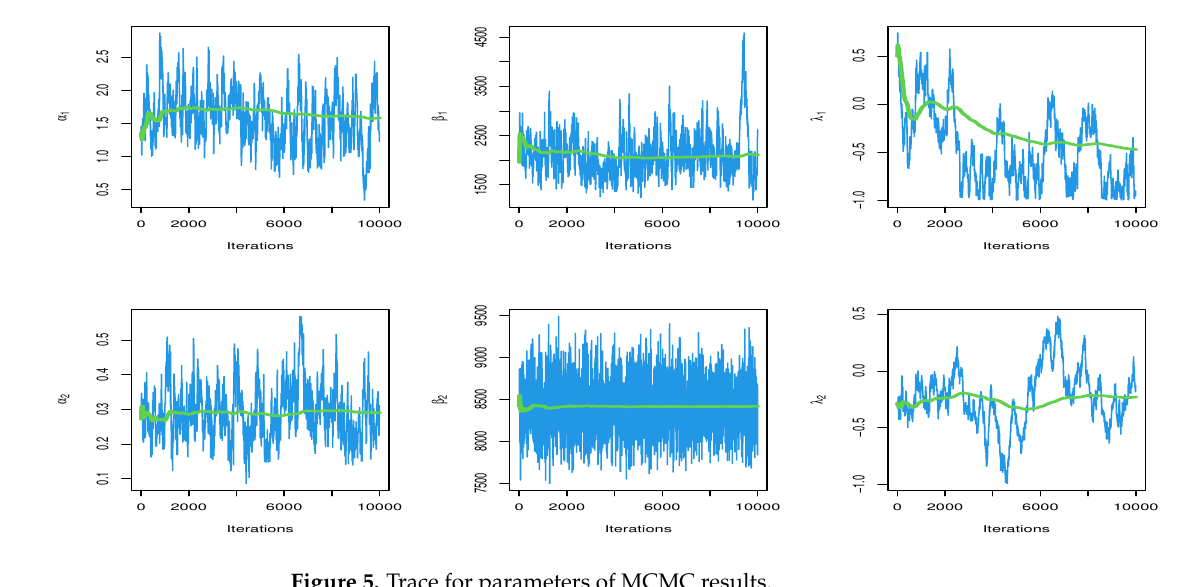
Figure 5. Trace for parameters of MCMC results.